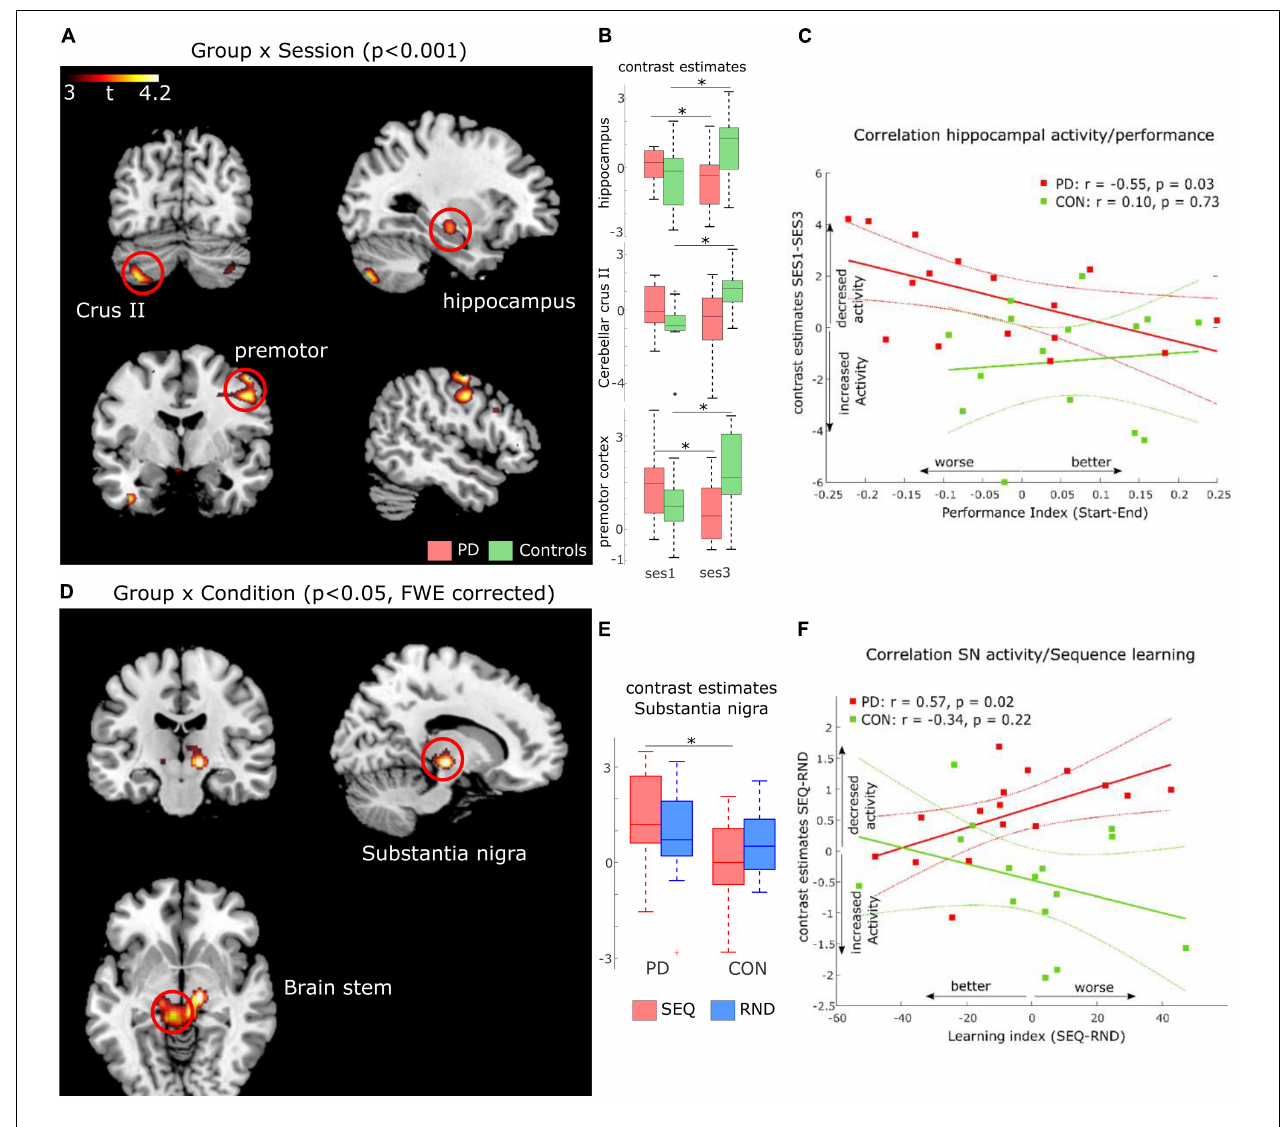
FIGURE 3 | FMRI results. (A) Activation maps for Group (PD, controls) x Session (SES1, SES3) interactions at p < 0.001, uncorrected voxel-level threshold. (B) Contrast estimates derived from activation clusters shown in A. Boxplots show significant increased activity in controls and decreased activity in PD. (C) Correlation between activity increase in hippocampus and improved performance in both PD (red, significant) and healthy controls (green, non-significant). (D) activation maps for Group (PD, controls) × Condition (Sequence, Random) interactions at p < 0.05, cluster-level family-wise error corrected. (E) Contrast estimates derived from the activation cluster in substantia nigra (SN) shown in (D) . Boxplots show significant increased activity in PD compared to controls during sequence blocks. (F) Correlation between activity increase in SN and worse sequence learning in both PD (red, significant) and healthy controls (green, non-significant).